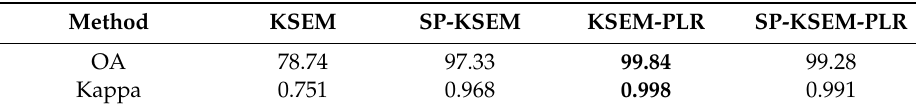
Figure 8. Classification results of the simulated image with different methods: ( a ) superpixel map; ( b ) enlarged view of the upper right corner of the superpixel map; ( c ) SEM classification utilizing the K distribution (KSEM); ( d ) superpixel (SP)-KSEM; ( e ) KSEM-PLR; and ( f ) SP-KSEM-PLR. Table 1. Classification accuracy measures of the simulated image.